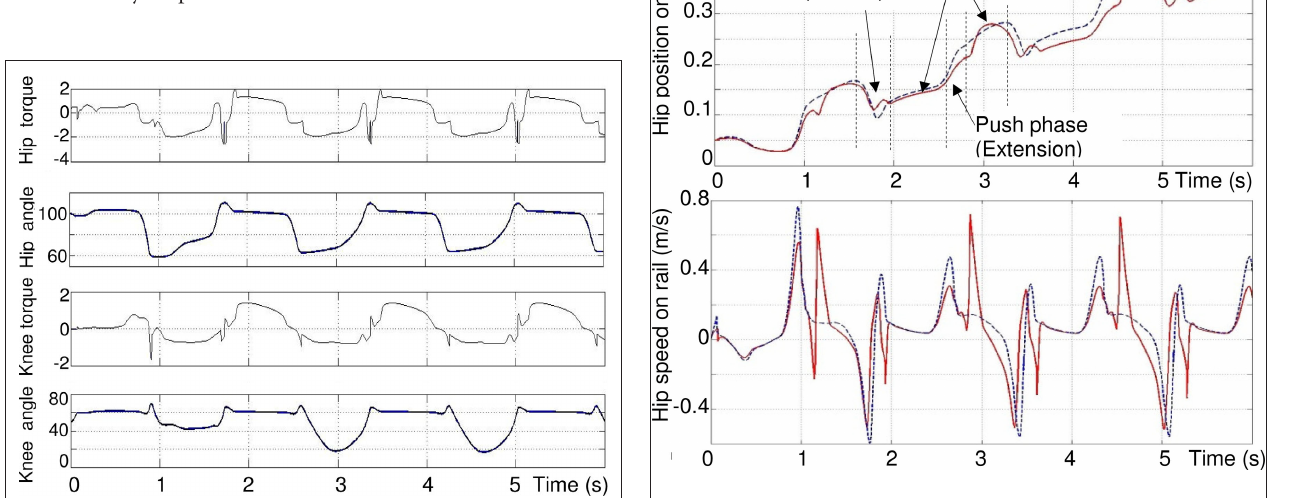
FiguRe 10 | From top to bottom: torque (N.m) and angle (degree) of hip and knee. θ = 105 ° , θ = 50 ° , θ = 90 ° , θ = 10 ° ES,h FS,h ES,k FS,k